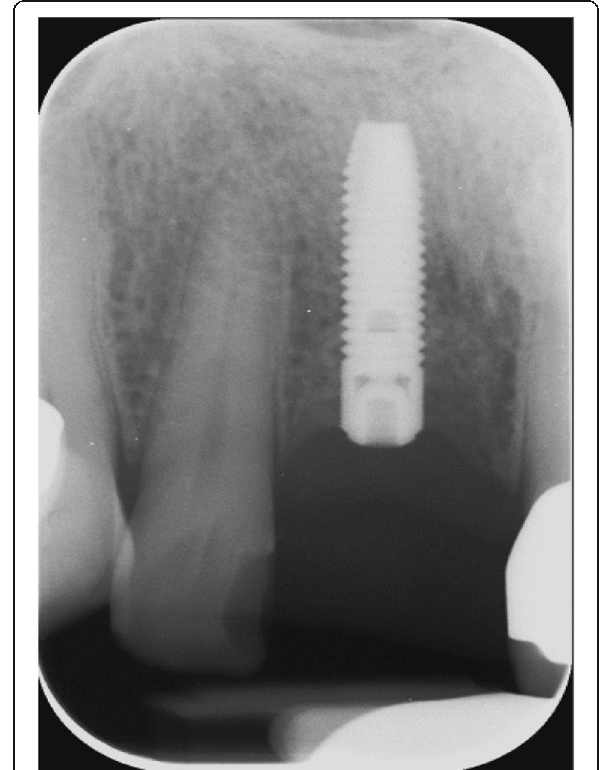
Fig. 15 Single tooth X-ray, showing a constant bone level 7 months after implant